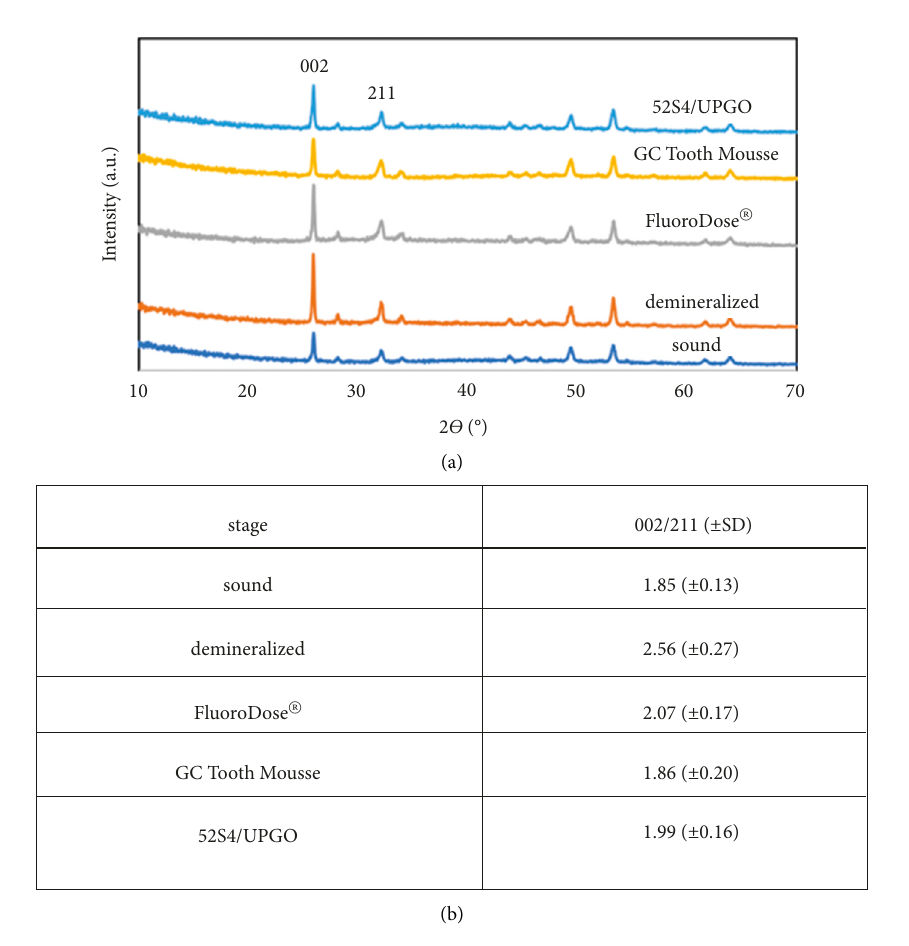
Figure 5: XRD patterns (a) and 002/211 ratios of enamel specimens at different stages (sound, demineralized, and after remineralization by FluoroDose ® , GC Tooth Mousse and 52S4/UPGO, n